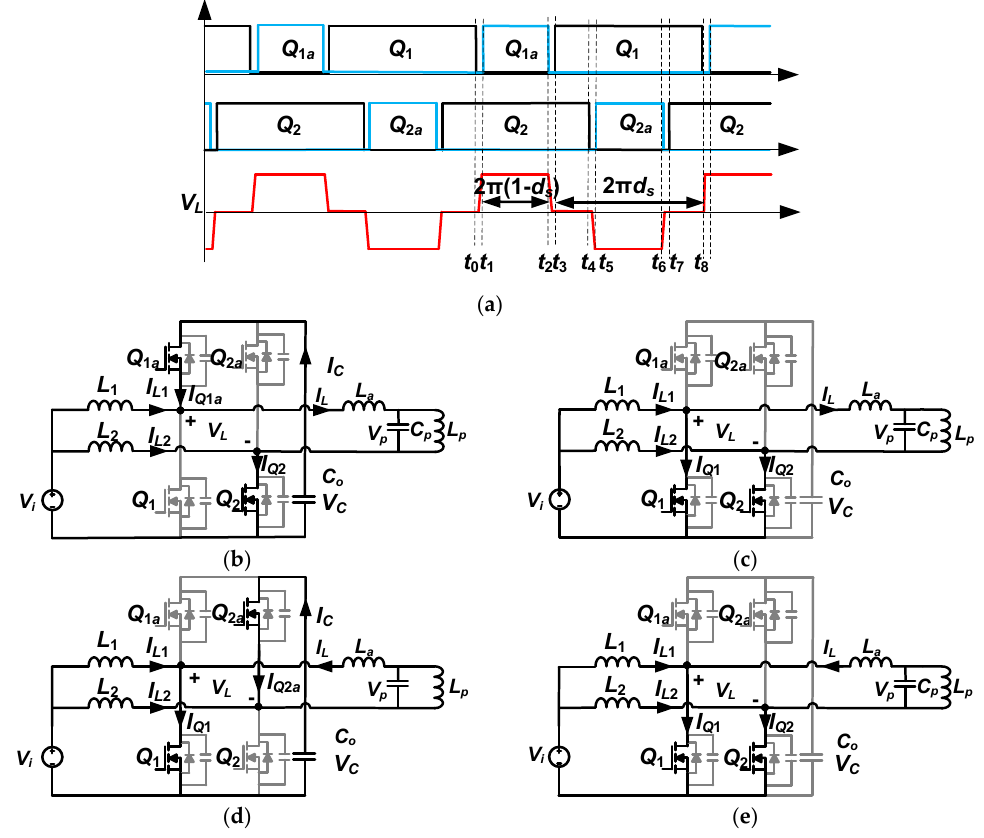
Figure 2. ( a ) Typical operation patterns of the CFI, ( b ) t 1 ~t 2 ; ( c ) t 3 ~t 4 ; ( d ) t 5 ~t 6 ; ( e ) t 7 ~t 8 .